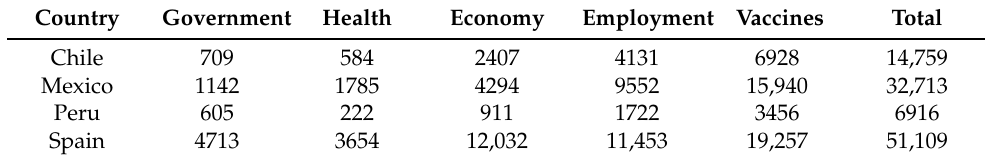
Table 3. Number of tweets resulting from the data filtering processes by topic and country of